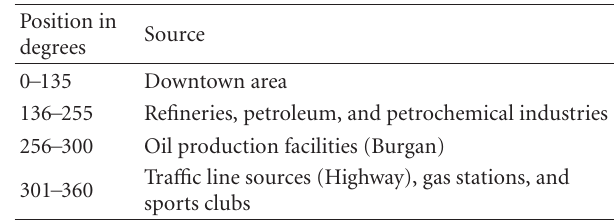
Table 5: Position distribution around outdoor data collection point in Al-Riqa urban area.